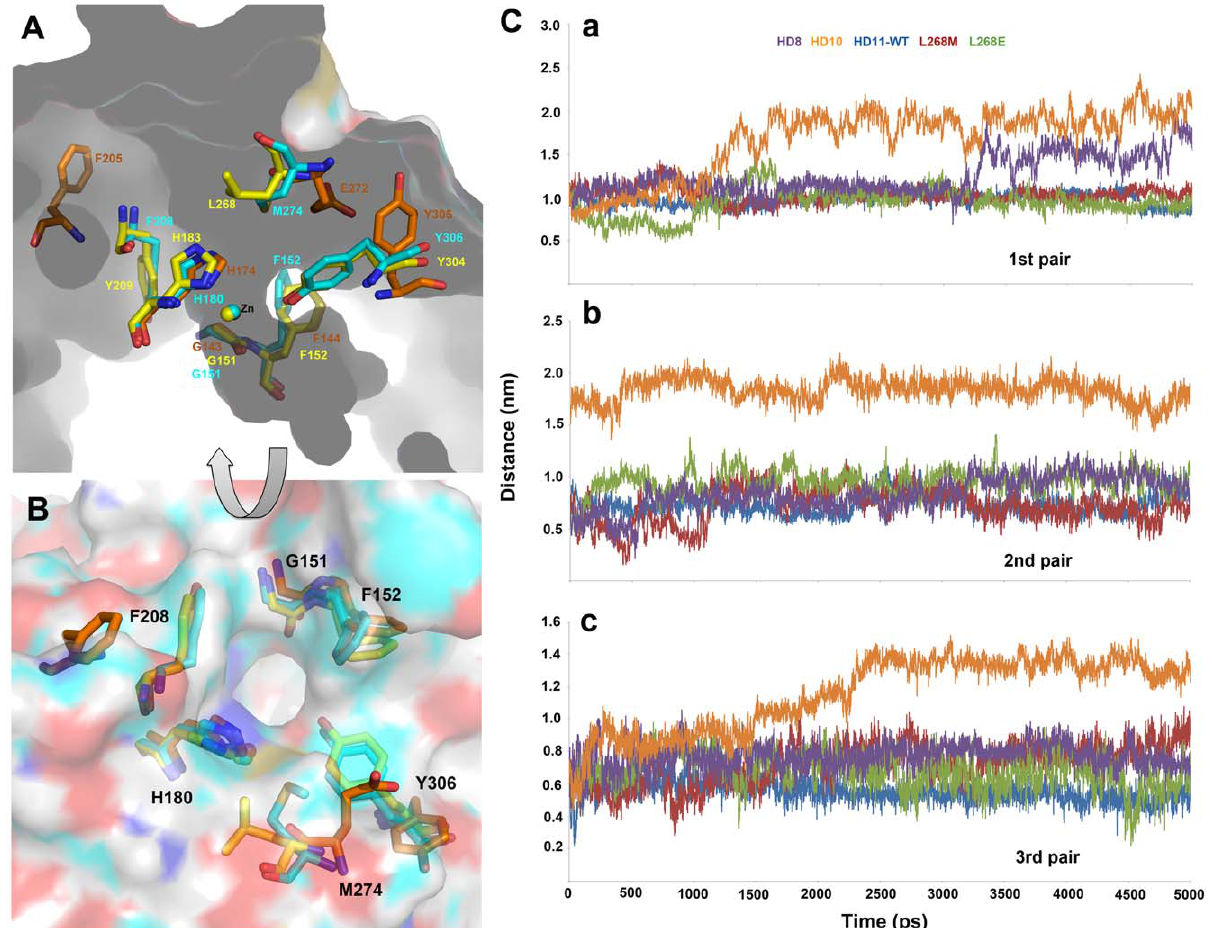
Figure 5. Comparison of distances between tunnel forming residue pairs in all HDACs. (A) Inner view of the tunnel in HDAC8 and conserved tunnel forming residues present in HDAC8, 10 and 11 enzymes. (B) Top view of the tunnel and the residues arrangement. (C) The distances calculated between three pairs of tunnel forming residues in all systems. doi:10.1371/journal.pone.0049327.g005 PLOS ONE |